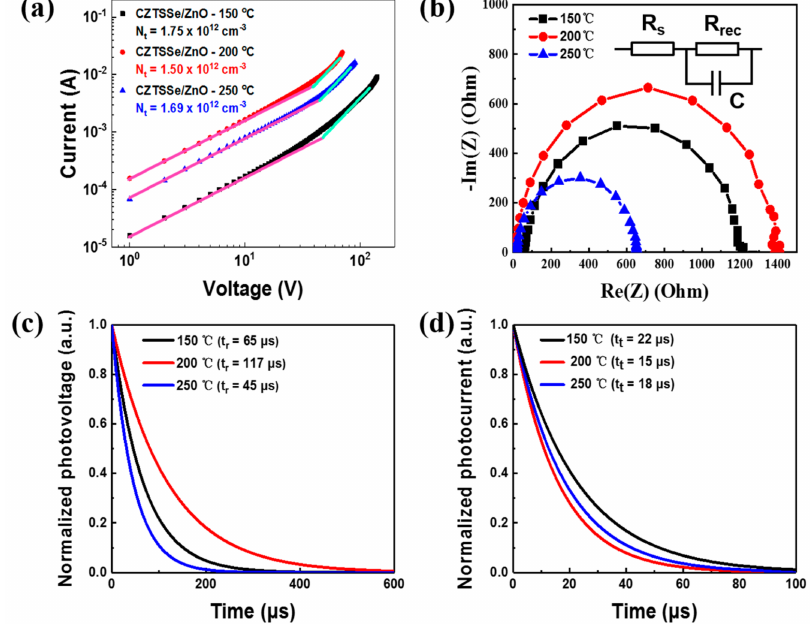
Figure 6. ( a ) The SCLC of CZTSSe/ZnO films produced with different annealing temperatures. The interfacial characterization of the three flexible CZTSSe/ZnO solar cells: ( b ) EIS plots, ( c ) TPV decay curves, and ( d ) TPC decay